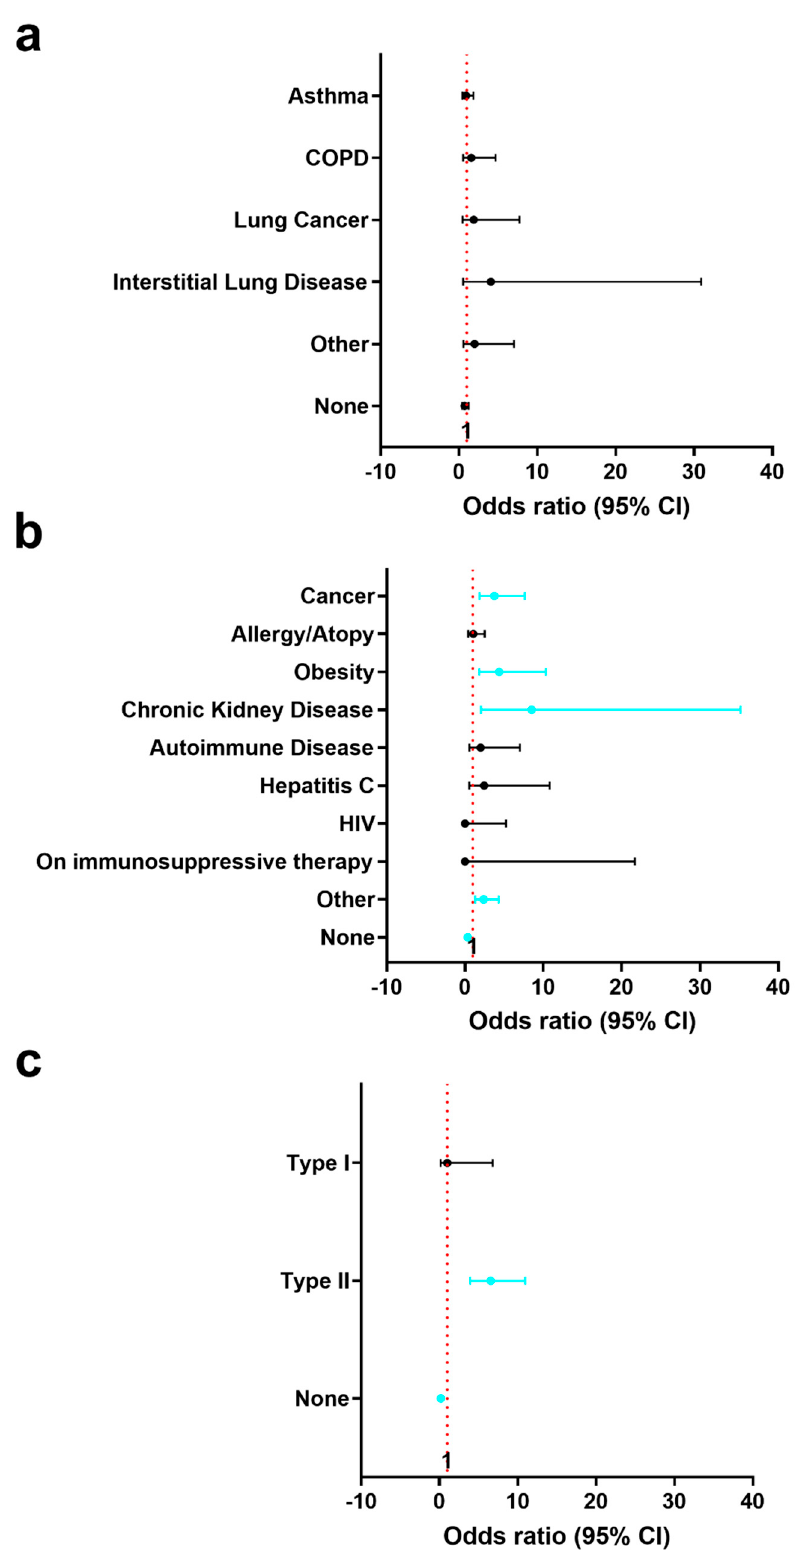
Figure 2. Patients with a history of CVD had significantly more cancer, obesity, chronic kidney disease and type II diabetes as pre-existing conditions. Patients with a history of CVD were compared to those without CVD to assess differences in ( a ) pre-existing lung disease history ( n = 659), ( b ) other pre-existing condition history ( n = 658) and ( c ) history of diabetes ( n = 662). Data shown as mean ± 95% confidence interval by Fisher’s exact test (turquoise color: p < 0.05).